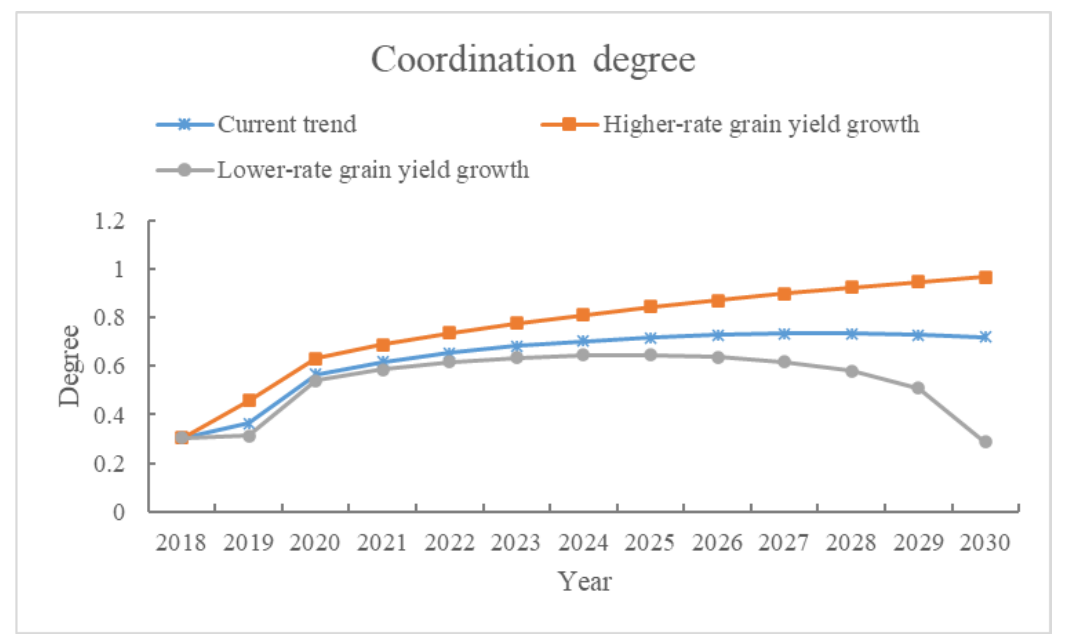
Figure 9. Coordination degree under three scenarios.